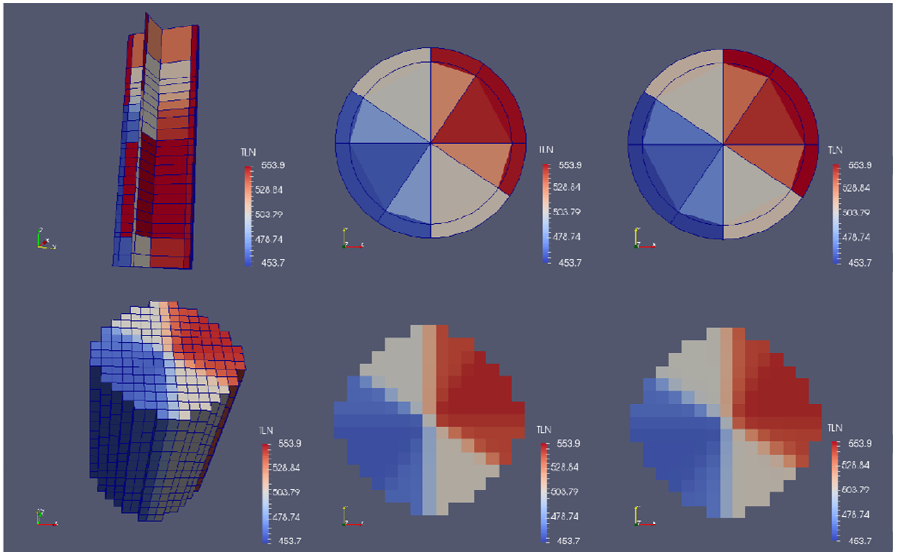
Figure 18. The coolant temperature distributions in the CY-V and CA-V of the AP1000 reactor (from left to right, from top to bottom: 3D field/2D field at the core inlet/2D field at the core outlet of CY-V, 3D field/2D field at the core inlet/2D field at the core outlet of CA-V).